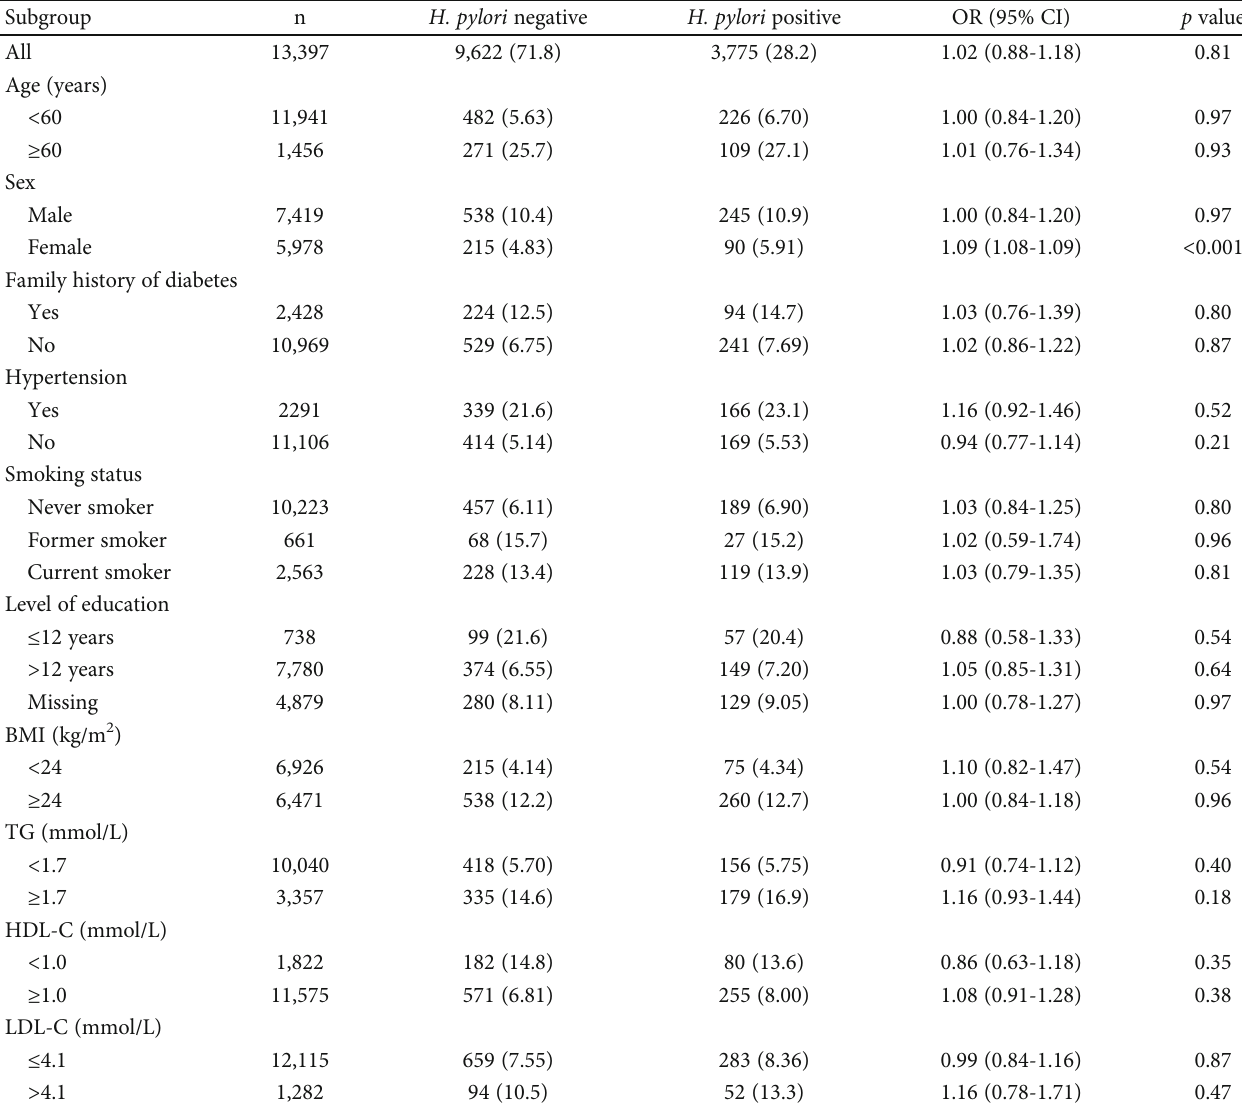
Table 3: Subgroup analysis of the association between H. pylori infection and diabetes †